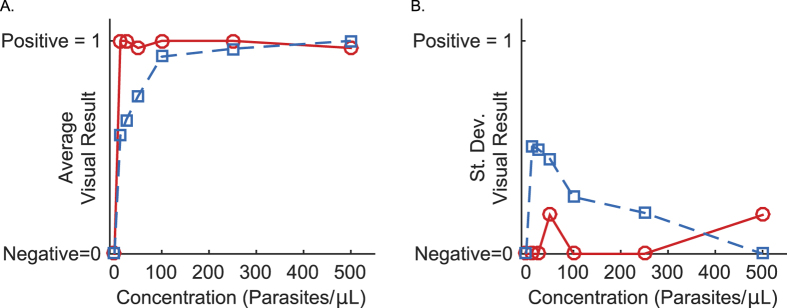
(A) The average visual interpretation scores, and (B) the standard deviation of the visual interpretation scores of experienced observers (red circles, solid line, n = 10) and novice observers (blue squares, dashed line, n = 9).